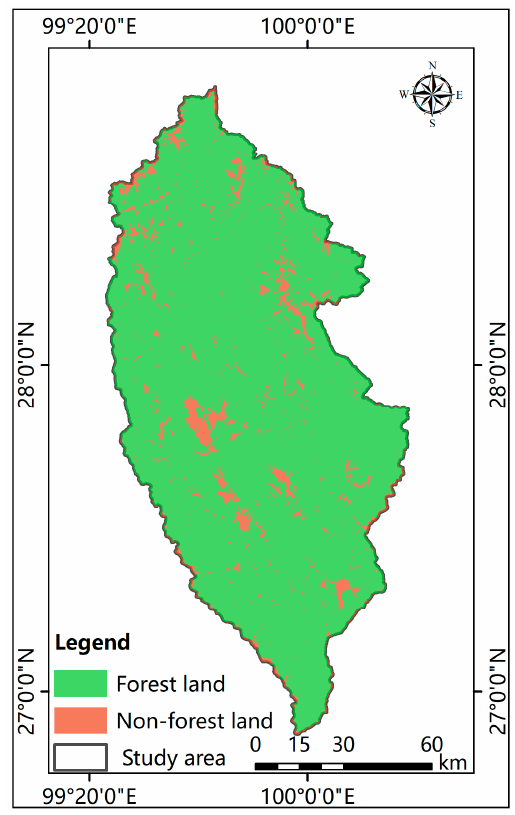
Figure 2. Statistics forest land change data in 2021.